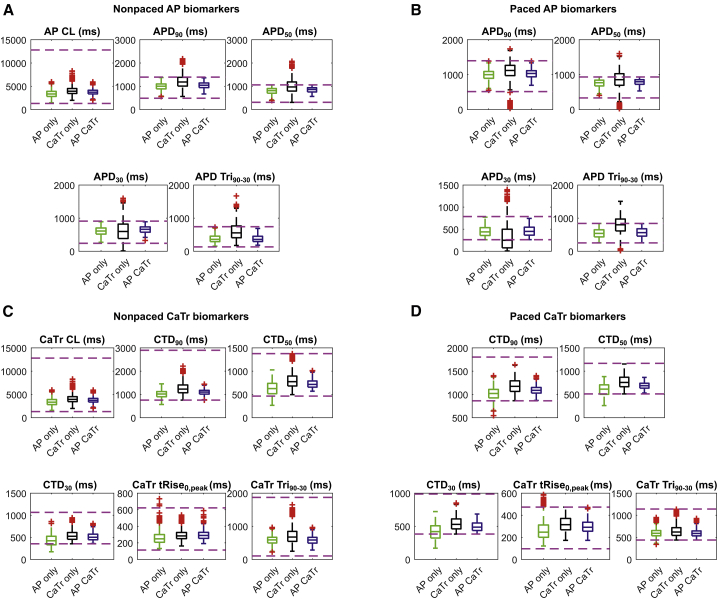
AP (A and B) and CaTr (C and D) biomarker distributions in the three populations of hiPSC-CM models, calibrated with in vitro AP biomarkers only (green), CaTr biomarkers only (black), or both (blue). In each box, the central mark is the median of the population, box limits are the 25th and 75th percentiles, and whiskers extend to the most extreme data points not considered outliers. Red crosses represent outliers. The dashed magenta lines represent the lower and upper bounds of the experimental recordings, as reported in Table 1. To see this figure in color, go online.